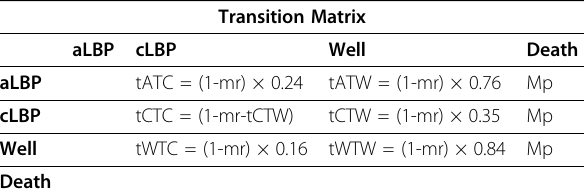
Table 4 Transition matrix (Usual care)